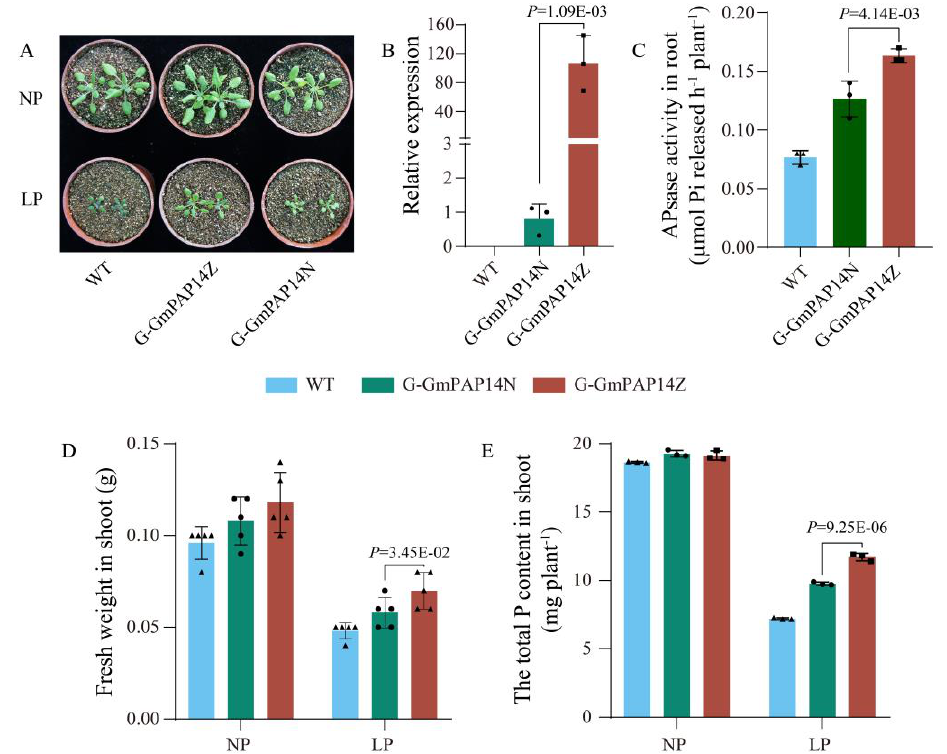
Figure 5. Variational analysis of the GmPAP14 gDNA in transgenic Arabidopsis . ( A ) Appearance of 30-day-old seedlings after treatment with normal P (NP, 1 mmol/L KH 2 PO 4 ) and low P (LP, 1 mmol/L phytate). ( B ) Relative expressional analysis of GmPAP14 in transgenic plants with G - GmPAP14Z and G - GmPAP14N . All data represent the means ± SD, n = 3. Error bars represent the SDs. ( C ) Secreted APase activities in the roots of transgenic and wild-type plants. APase activity was expressed as ρ -NP released per hour per plant. All data represent the means ± SD, n = 3. Error bars represent the SDs. ( D ) Fresh weights of shoots of transgenic and wild-type plants under LP and NP conditions. All data represent the means ± SD, n = 5. Error bars represent the SDs. ( E ) Measurements of P content in shoots. After 30 days of growth, shoots were harvested separately for P content measurements. WT, wild-type plant; G-GmPAP14Z, transgenic plants with G-GmPAP14Z ; G- GmPAP14N, transgenic plants with G-GmPAP14N . The data are the means ± SD, n = 3. Error bars represent the SD. One-way ANOVA was used to identify the differences between the data.